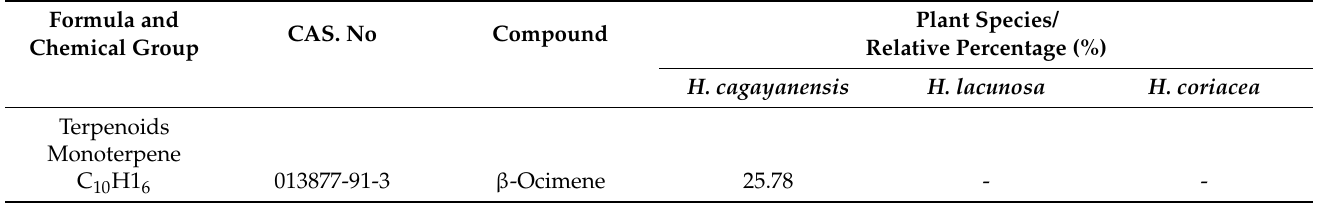
Table 2. List of secondary metabolites compounds found in flowers of H. cagayanensis , H. lacunosa , and H. coriacea species. The relative amount (in %) of scent compounds are listed according to compound